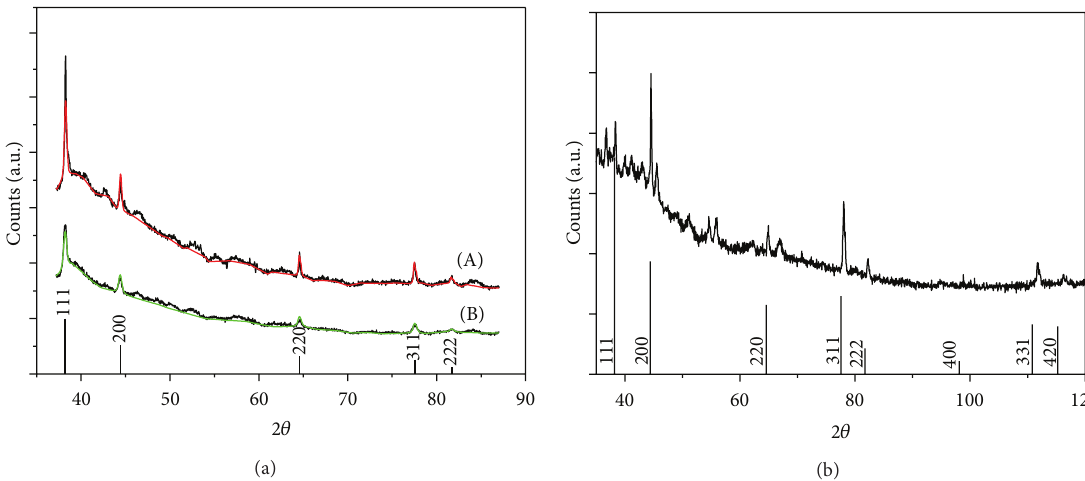
Figure 3: XRD of gold clusters embedded in amorphous polystyrene before (A) and after (B) purification by film dipping in pure acetone (left-side picture) and XRD (𝜃−2𝜃 run ) of the AuMMI/PS system (right-side picture). The red and green lines in Figure 3(a) are the Rietveld best-fitted profiles of the experimental data.